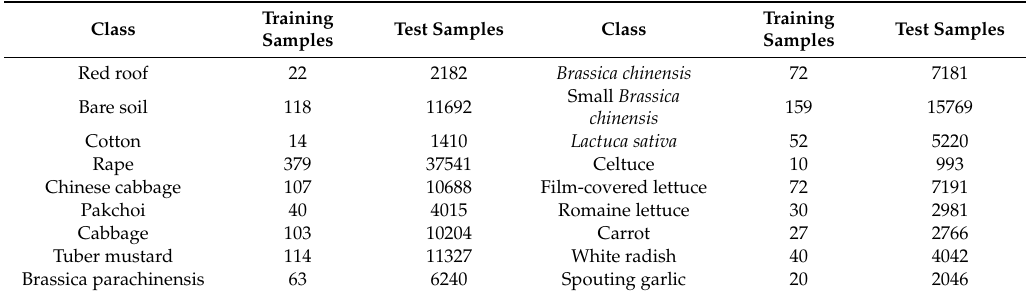
Figure 7. The Honghu dataset: ( a ) the true-color image; ( b ) the ground-truth map. Table 4. The training and test sample information for the Honghu dataset.